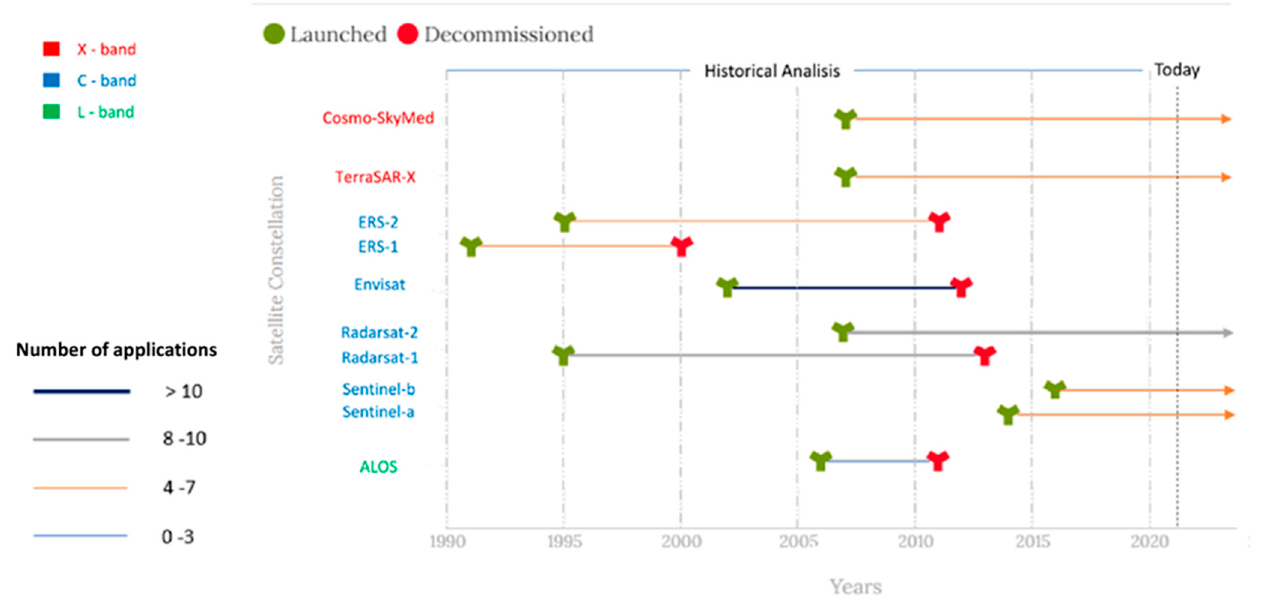
Figure 10. Satellite SAR constellation usage considering all the applicative contributions.